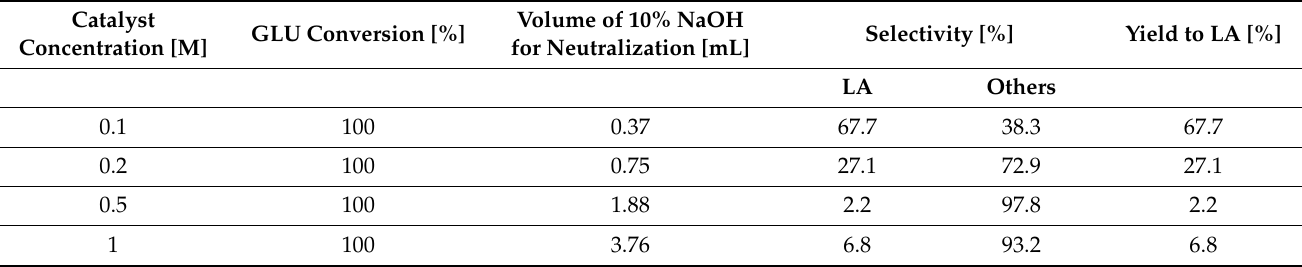
Table 3. The results of HPLC analysis for the catalytic conversion of glucose using homogeneous H 2 SO 4 catalyst in the liquid phase, 2 h process and at 220 ◦